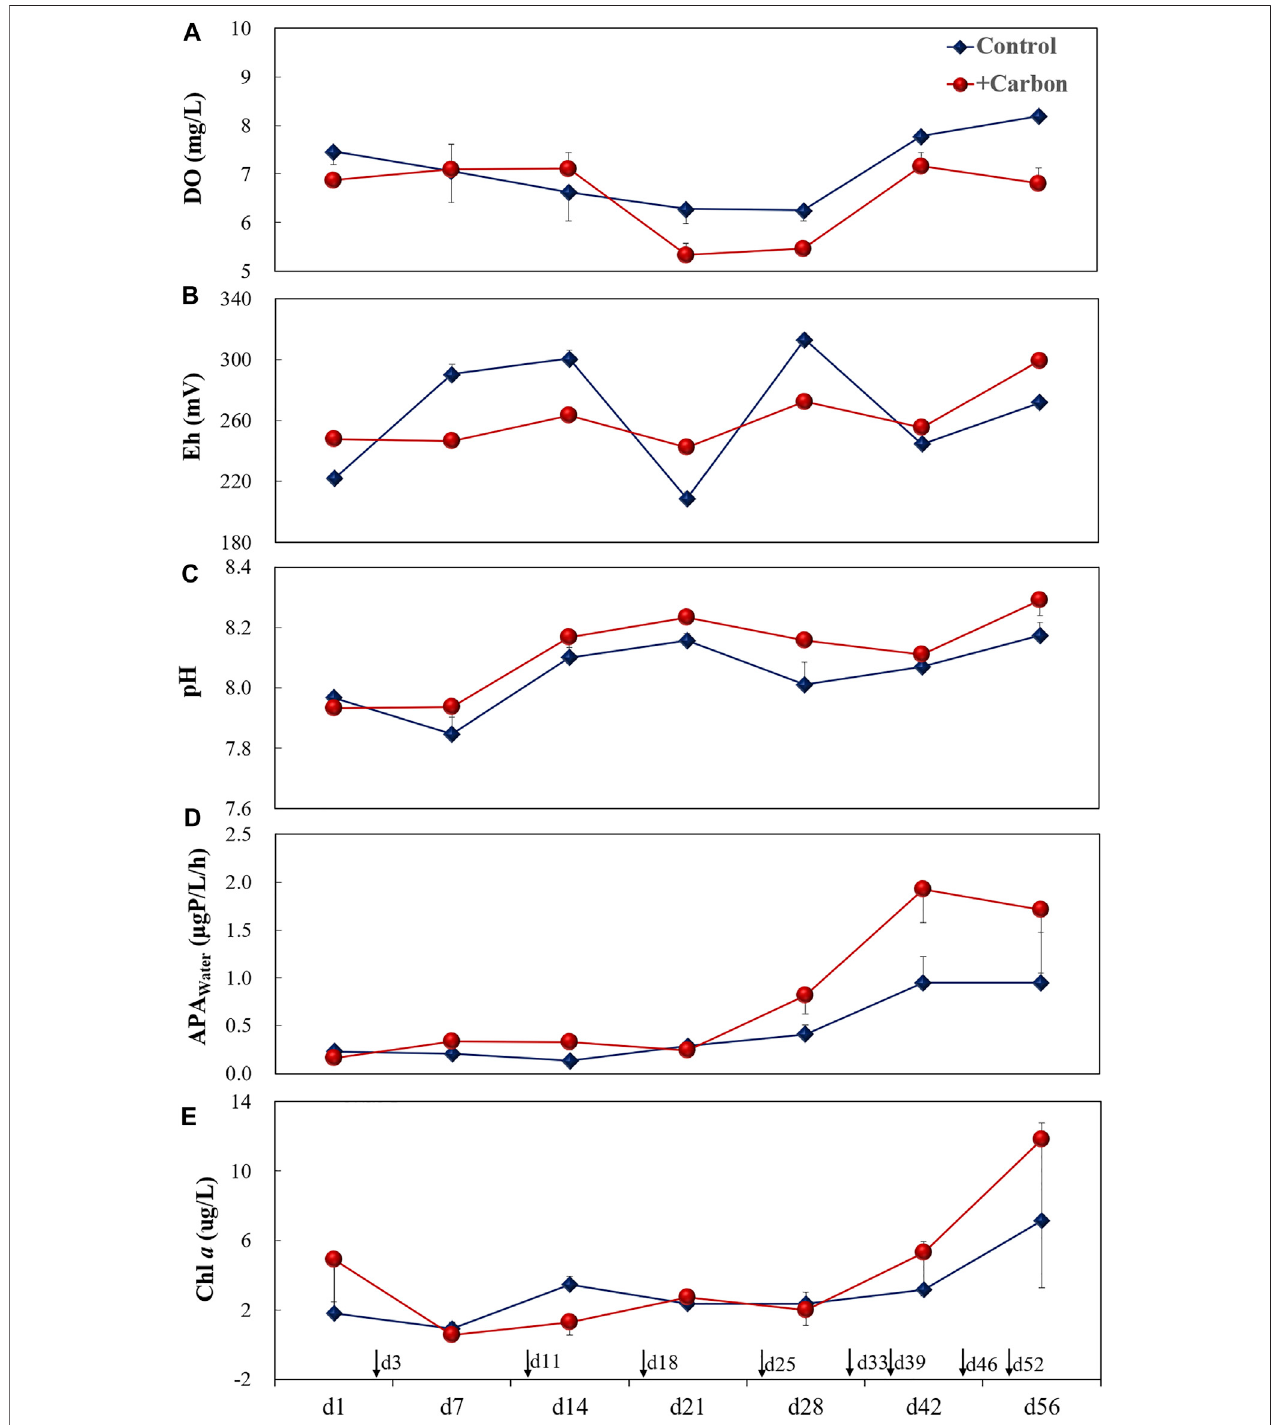
FIGURE 3 | Changes (mean ± SE) in DO (A) , Eh (B) , pH (C) , APA Tot (D) , and Chl a (E) for the various treatments during the experiment. Single-headed arrows indicate the time of carbon addition. DO, dissolved oxygen (mg L − 1 ); Eh, redox potential (mV); APA Tot , total alkaline phosphatase activity in water (µg P L − 1 h − 1 ); Chl a , phytoplankton chlorophyll a (µg L − 1 ); Control, control treatment without carbon addition; +Carbon, carbon addition treatment (equivalent to 5 mg C L − 1 ).